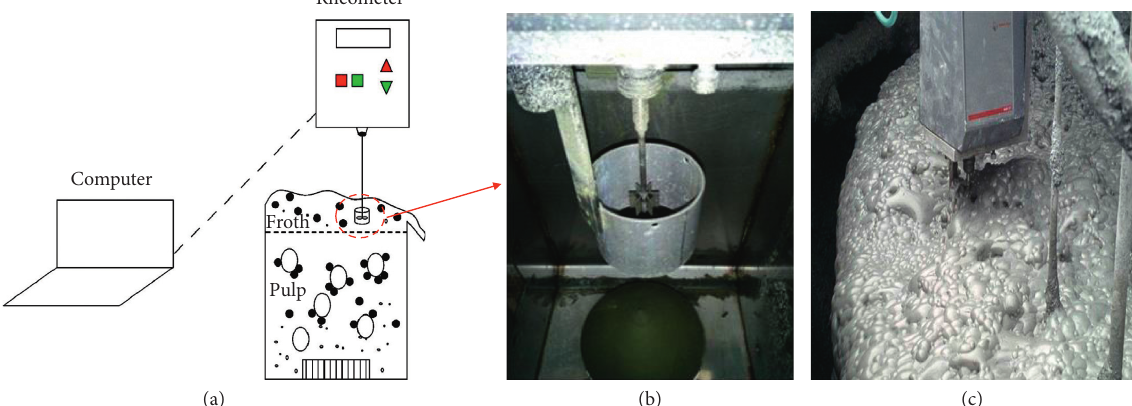
Figure 11: Froth rheology measurement device (the Anton Paar DSR 301 rheometer) by Li et al. [86]: (a) schematic diagram; (b) modified vane system; (c) setup of the rheometer in an industrial